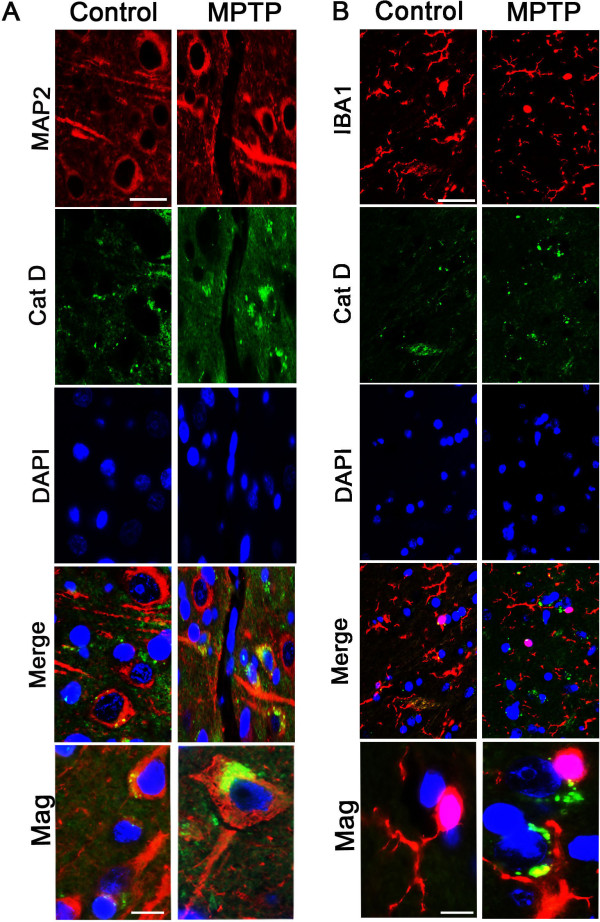
Double immunofluorescence of CatD with MAP2 and IBA1 in CN od MPTP monkey. (A) Double immunostaining was performed on MPTP CN sections with the neuronal marker anti-MAP2 (red) and anti-Cat D (green). The merged image illustrates a co-localization of Cat D with MAP2, confirming its presence in neurons. Bar = 20 μm. Higher magnification of single neuron is also provided (bottom panel, Mag). Bar = 5 μm. (B) Double immunostaining was performed on MPTP CN sections with the microglial marker anti-IBA1 (red) and anti-Cat D (green). The merged staining of Cat D with IBA1 conforms the absence of Cat D in microglial cells. Bar = 20 μm. Higher magnification (bottom panel, Mag). Bar = 5 μm.